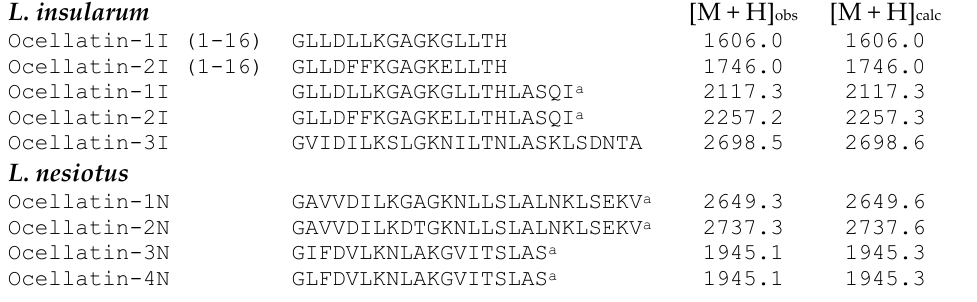
Figure 3. Amino acid sequences and molecular masses of the peptides isolated from norepinephrine-stimulated skin secretions from L. insularum and L. nesiotus . [M + H] obs denotes the observed molecular mass and [M + H] calc denotes the mass calculated from the proposed structures. a Denotes C-terminal α -amidation. (1–16) Indicates a truncated peptide.